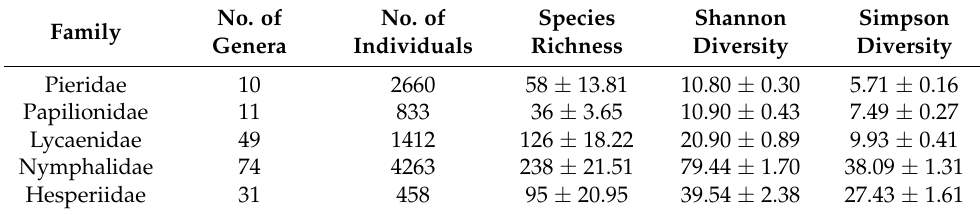
Table 1. Diversity indices of butterfly communities in the middle Qinling Mountains (mean ±